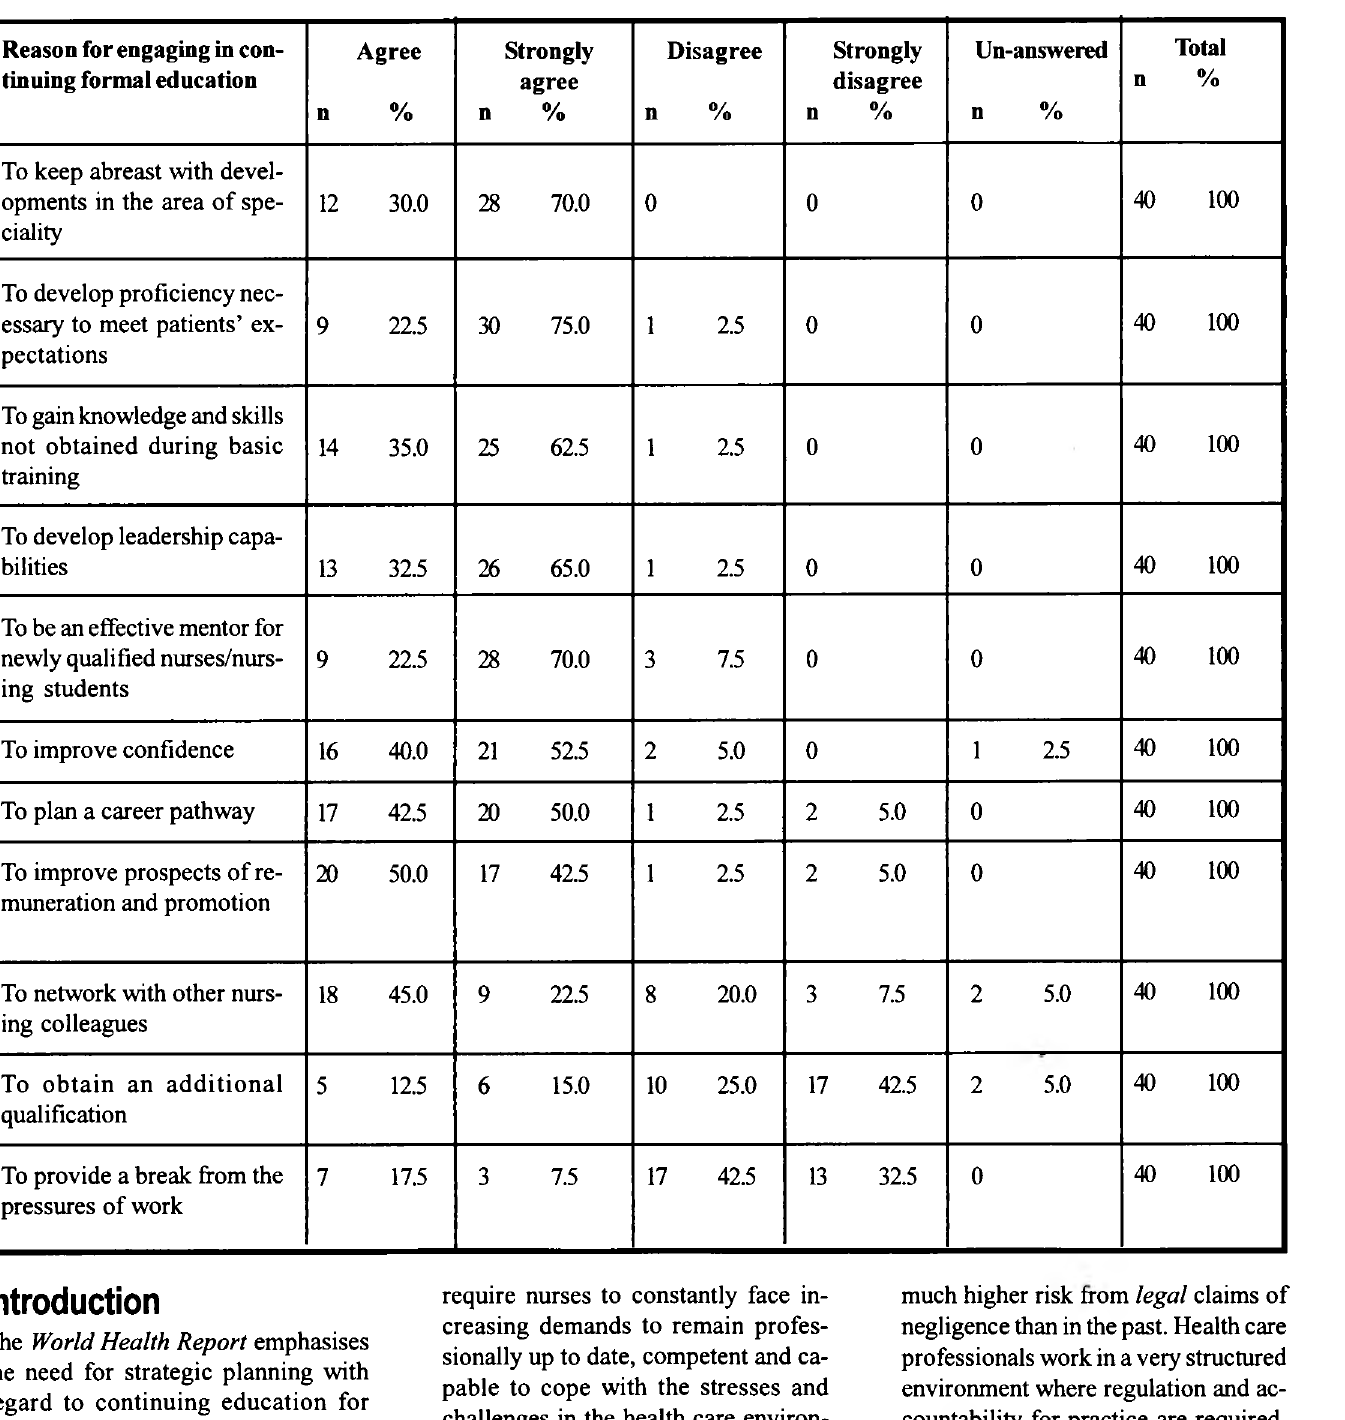
Table 1: Reasons for engaging in continual formal education (N=40) Reason for engaging in